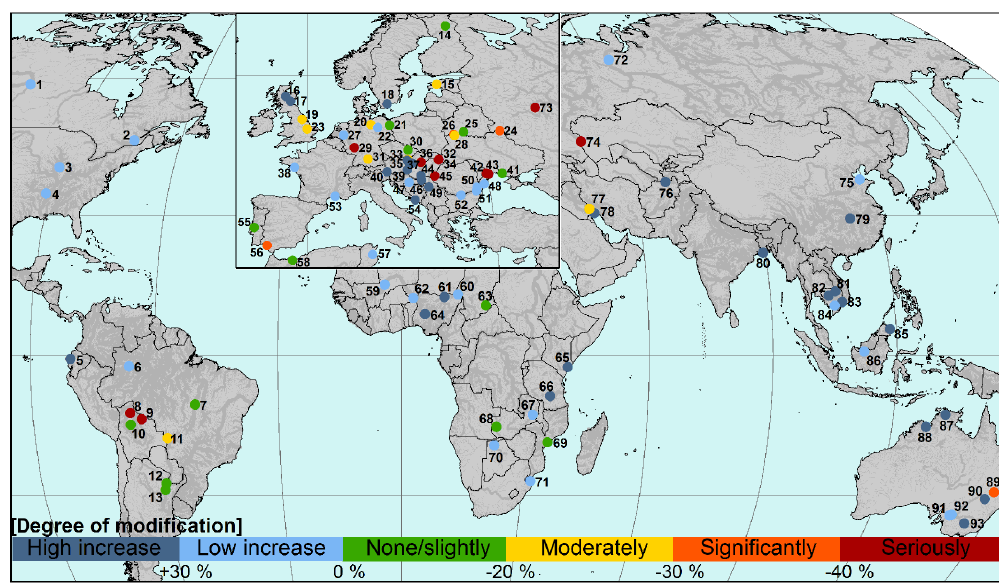
Figure 3. Global map of overbank flow alterations for selected riparian wetlands of international importance (nos. 1–93) as a consequence of the exclusive effect of climate change in the